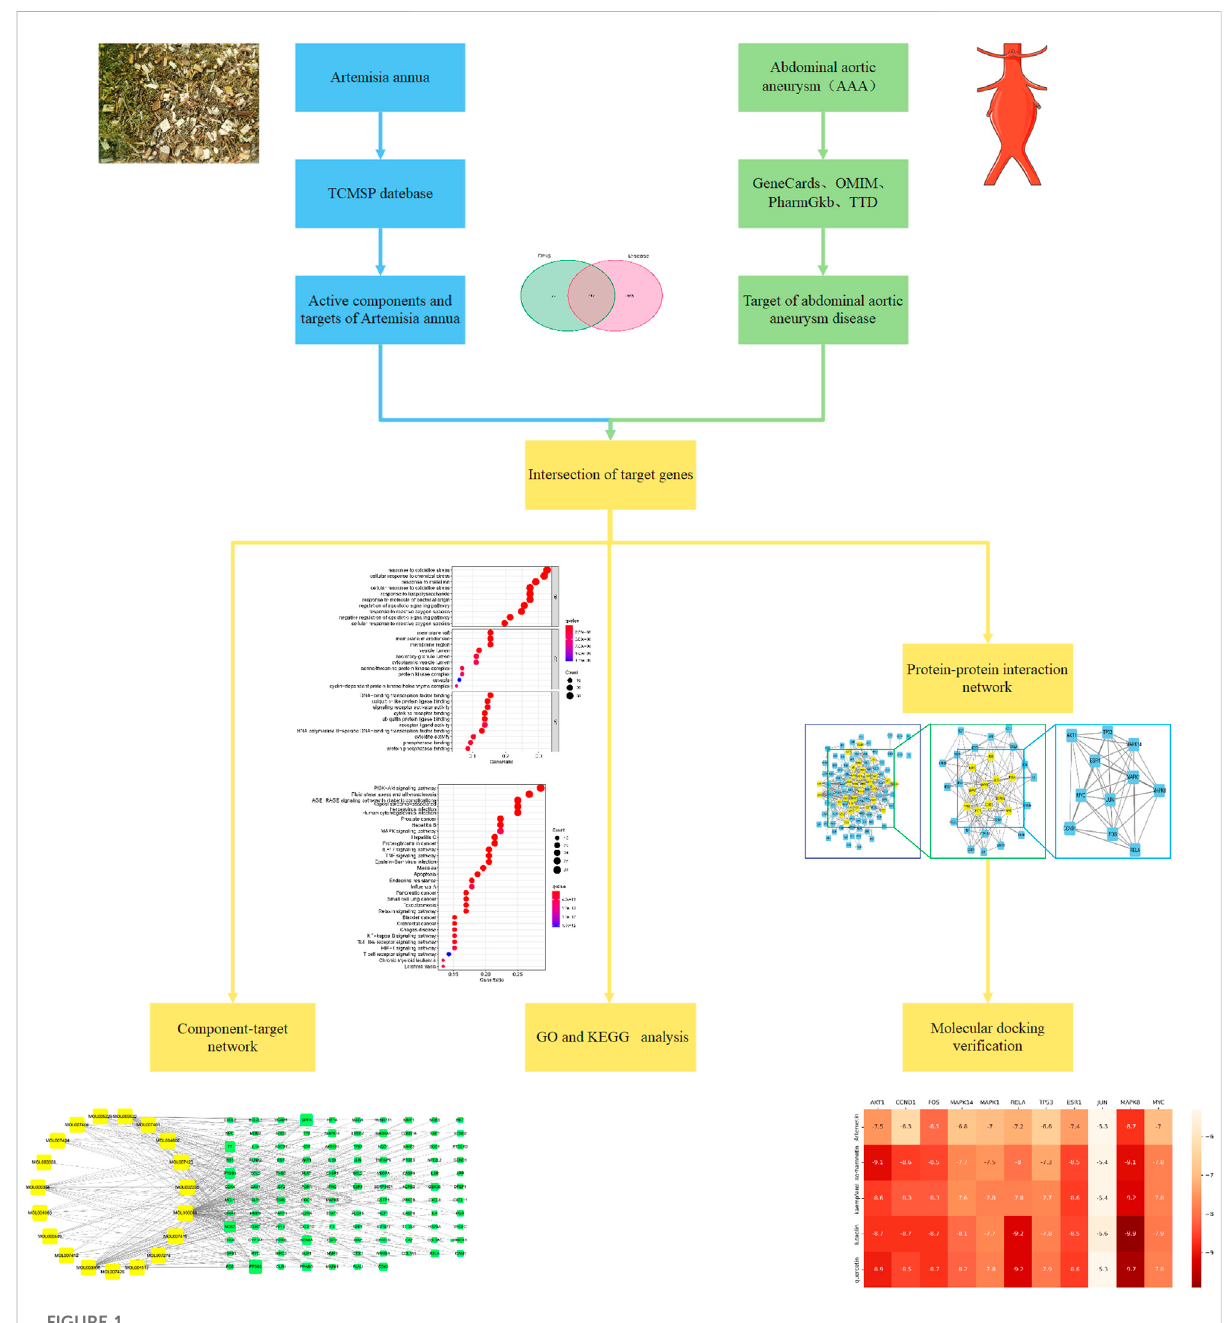
FIGURE 1 The fl owchart of this